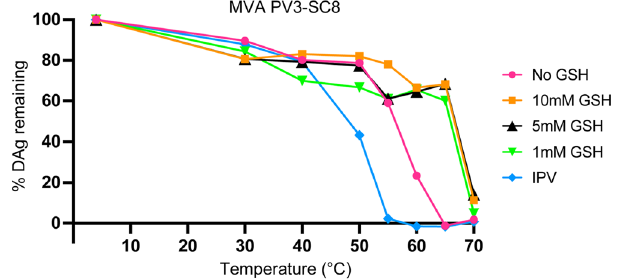
Fig. 4 GSH has a stabilising effect on PV VLPs in vitro. Proportion of D antigen reactivity remaining after heating in the presence or absence of 1, 5 and 10 mM GSH. Aliquots of IPV and VLPs were incubated at a range of temperatures and analysed by D Antigen ELISA; reactivity is expressed relative to samples incubated at 4 °C for the same period. Data were shown for PV3-SC8 VLPs expressed in mammalian cells.